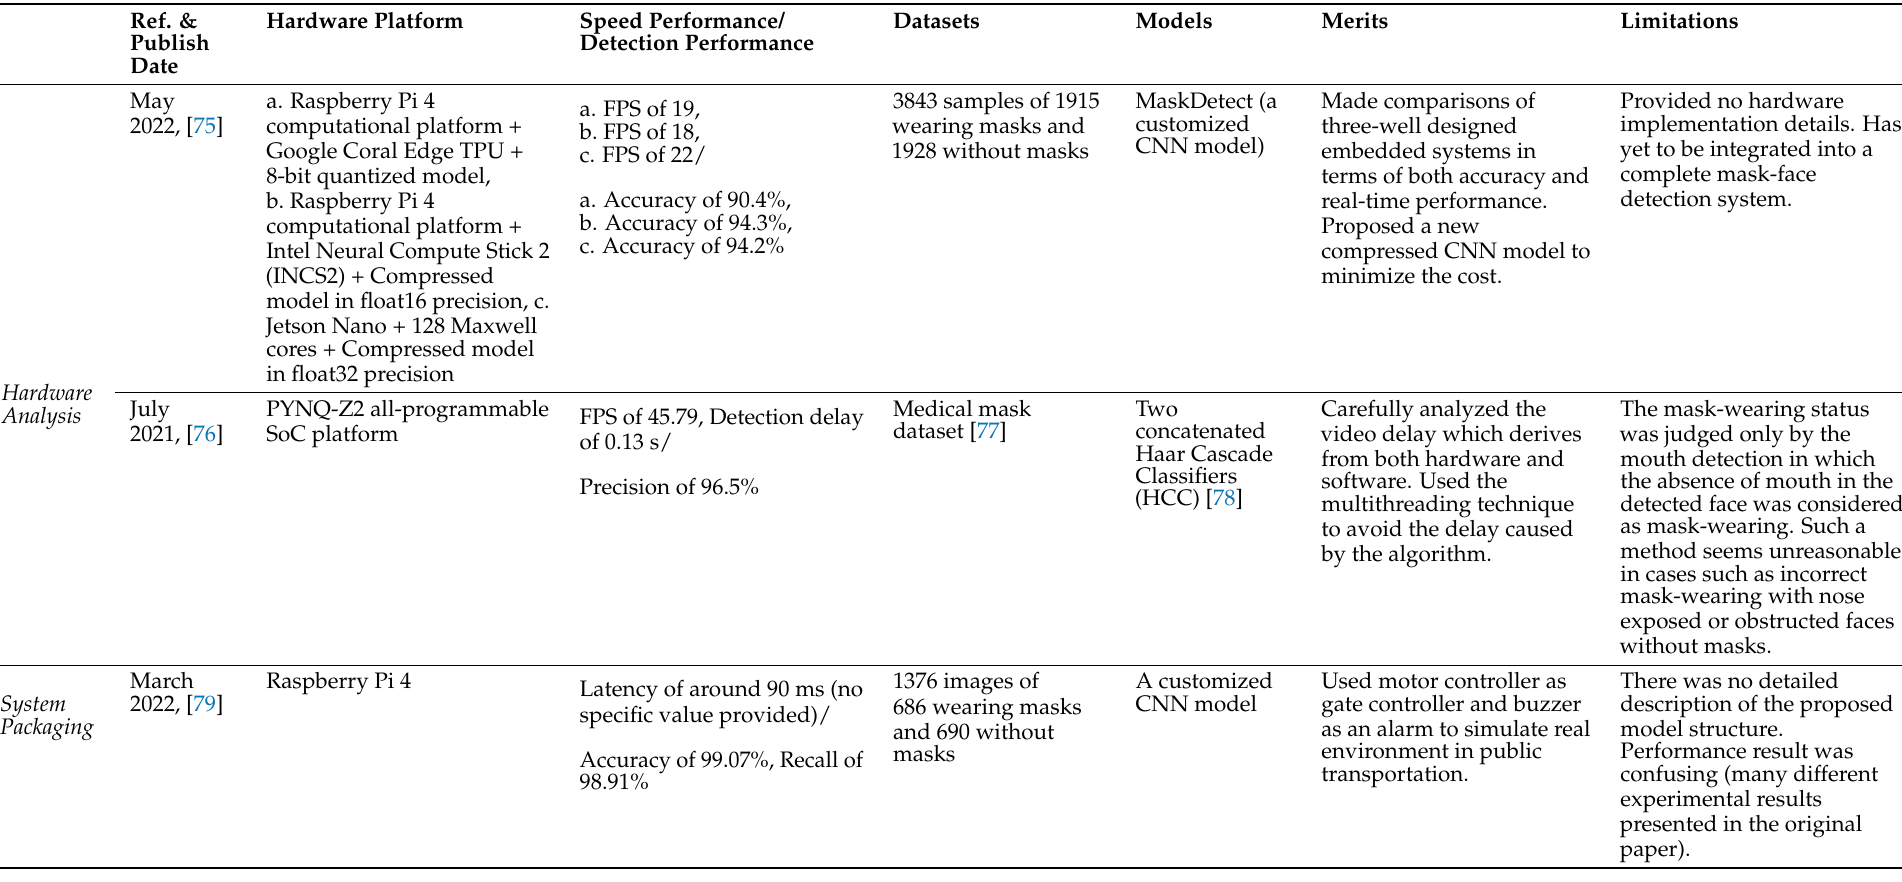
Table 4. Summary of mask-face detection hardware